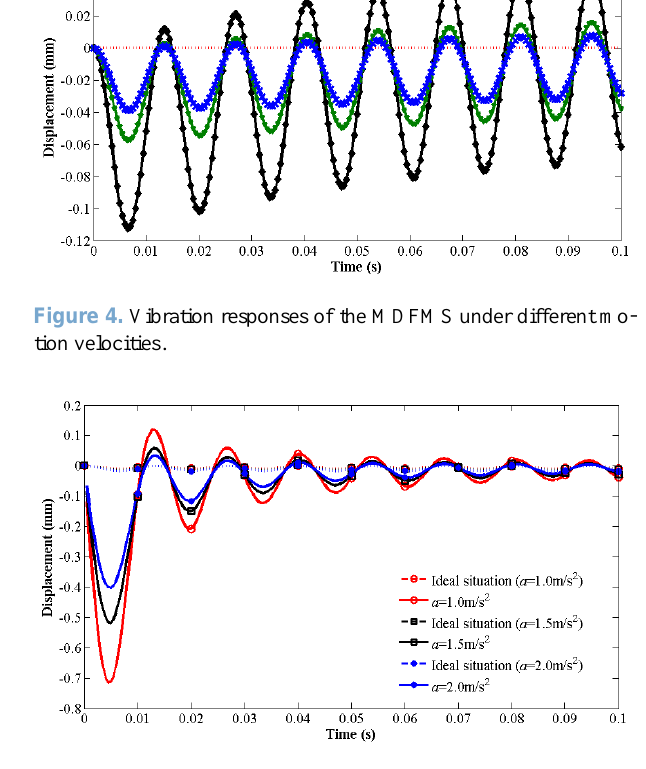
Figure 5. Vibration responses of the MDFMS under different mo- tion